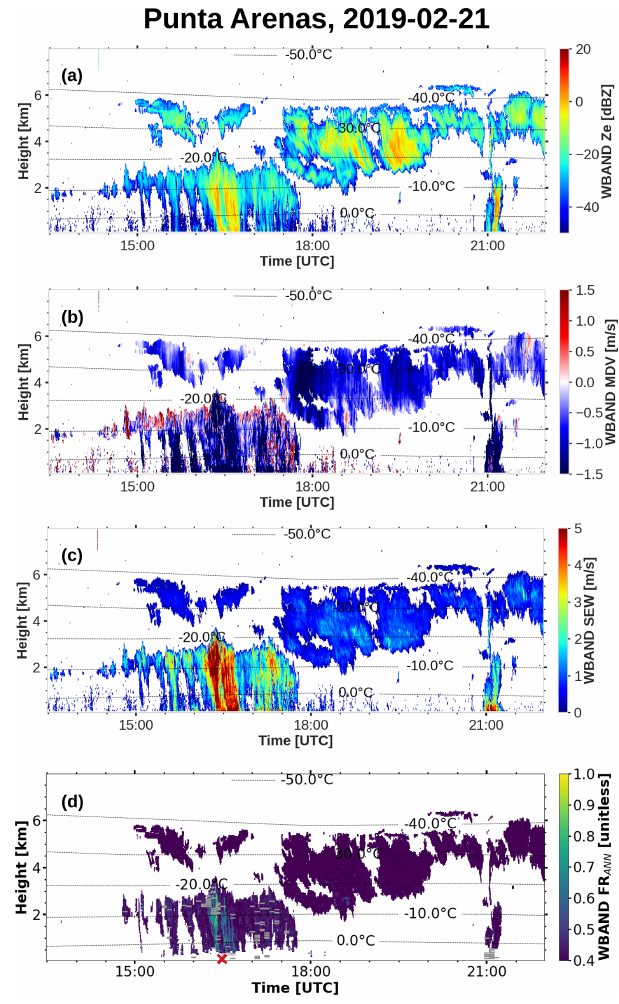
Figure 10. Radar moments measured by LIMRAD94 during the case on 21 February 2019. (a) Equivalent radar reflectivity in dBZ. (b) Mean Doppler velocity. (c) Spectrum edge width and (d) FR ANN predicted by ANN 2 (using, Ze, SEW, and skewness). The red cross marks the time (16:30UTC) when graupel particles were observed at the